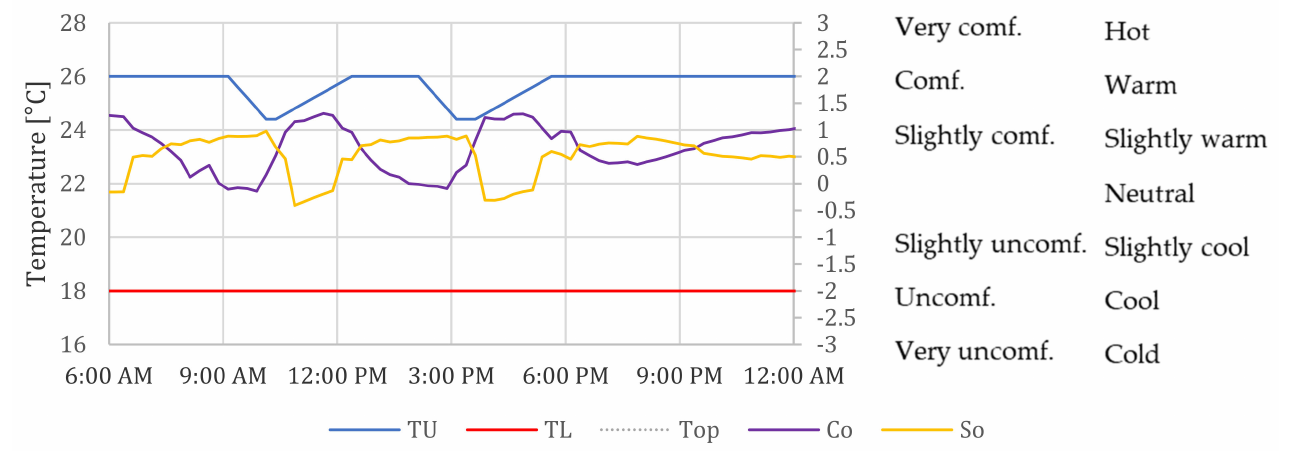
Figure 8. Adapting the upper setpoint TU based on the values for overall sensation (So) in terms of beeing “hot” to “cold” and overall comfort (Co) ranging from “very comfortble” to “very uncomfort- able” for a one-day simulation in August for Mannheim